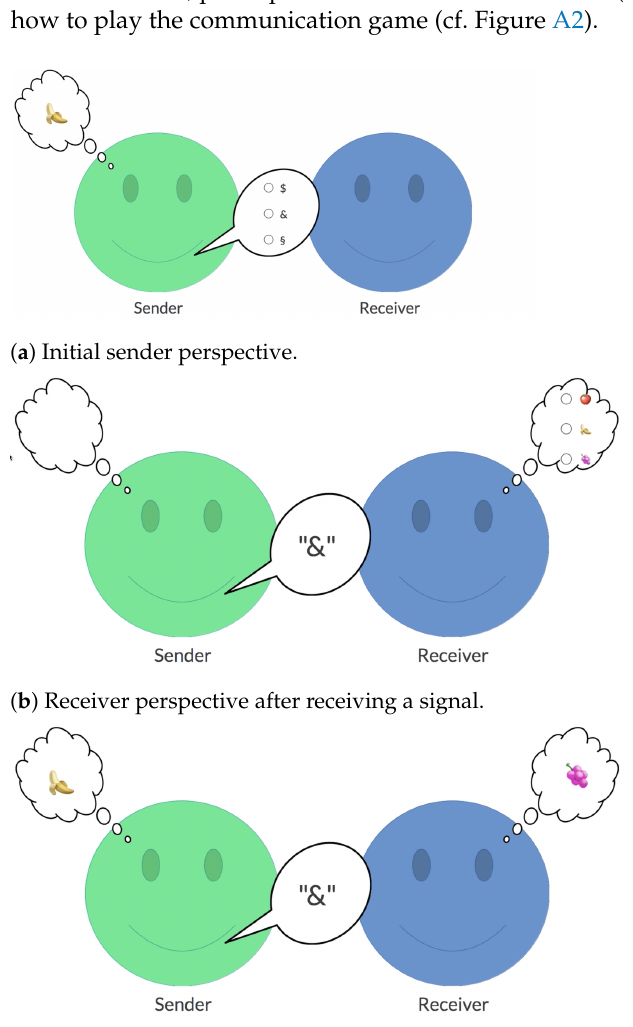
Figure A2. Screenshots of an exemplary interaction round for the LS game, with the green agent as sender and the blue agent as receiver. ( a ) Initial perspective of the green agent in sender role. Her private information state is ’banana’ (alternatives: ’apple’, ’grapes’), and she has to pick a signal, $, & or §. ( b ) Perspective of the blue agent (receiver role) after the sender has picked signal &. He cannot see the information state of the green agent and has to guess an information state as response: ’apple’, ’banana’ or ’grapes’. ( c ) Perspective of both agents after the receiver has picked ’grapes’ as response. Communication failed in this example, and both don’t